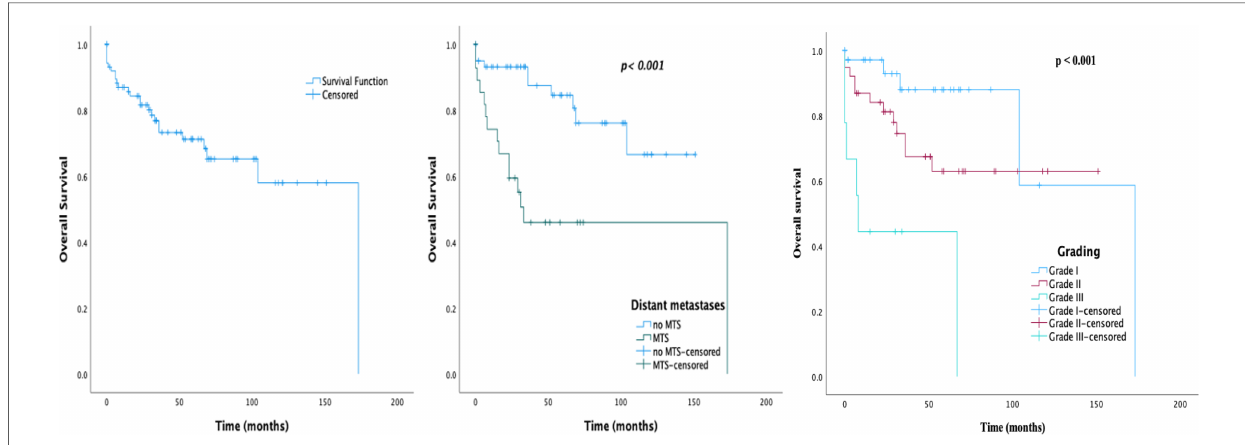
FIGURE 2 Survival graphs on 105 patients with sporadic PNEN diagnosis: ( A ) overall survival; ( B ) overall survival by MTS presentation; ( C ) overall survival by grade.